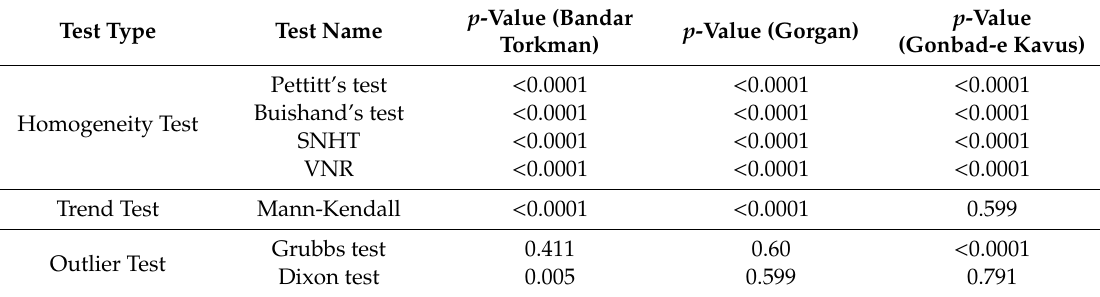
Table 2. Results of homogeneity, trend and outlier tests in three studied